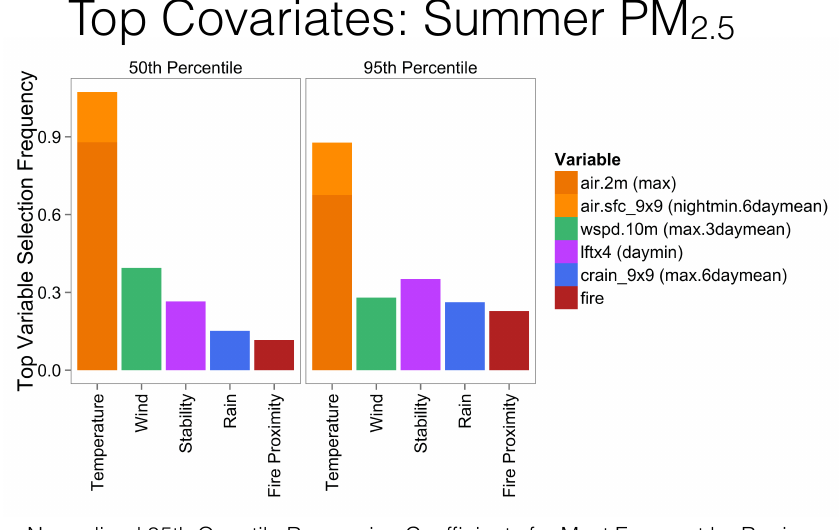
Normalized 95th Quantile Regression Coefficients for Most Frequent by Region